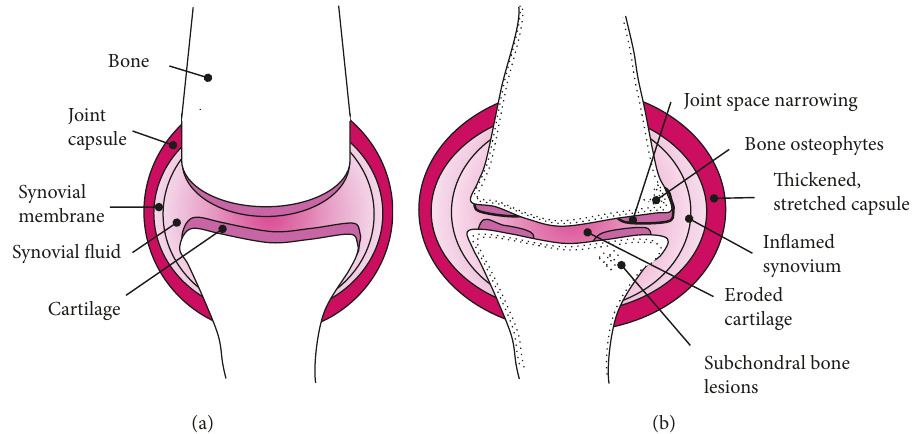
Figure 1: Diagram of the synovial knee joint in (a) a healthy individual and (b) an individual with mild osteoarthritis.